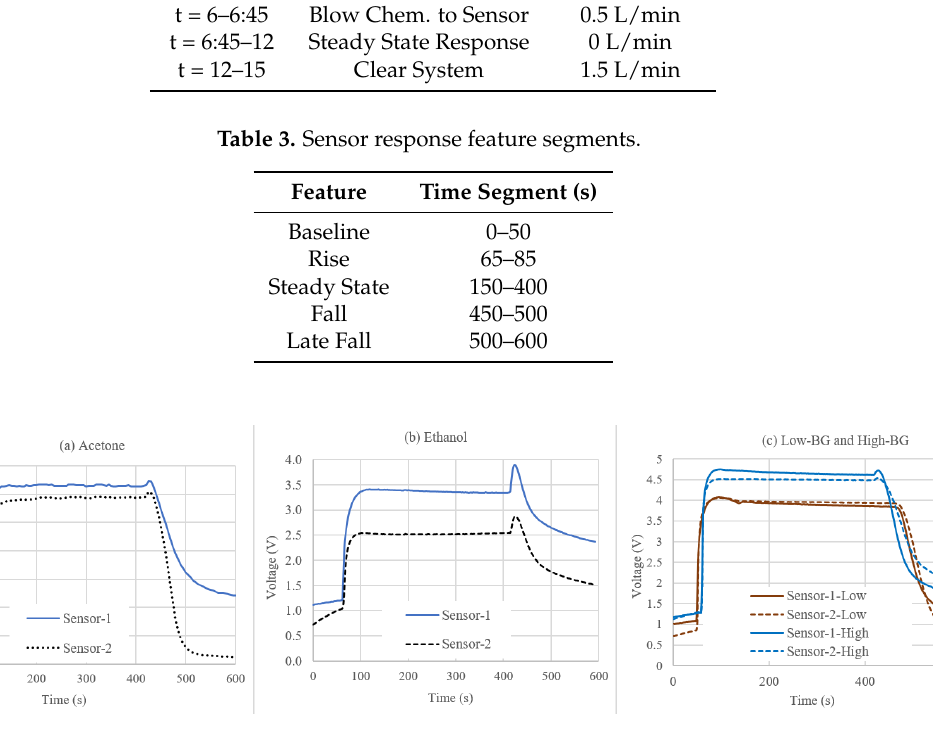
Figure 3. Sample sensor array responses showing results for: ( a ) acetone; ( b ) ethanol; and ( c ) mixed compounds representing low and high blood glucose levels. The spikes in ( b ) seen at the end of steady state and beginning of system clearing cycle were due to the residual ethanol in the VOC chamber, which was transported to sensor array chamber. This also indicated a slower ethanol